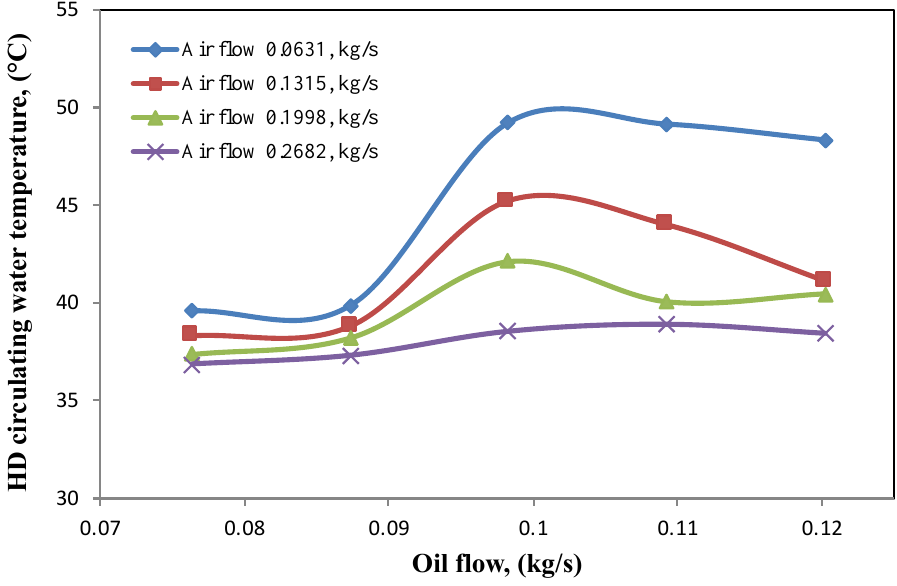
Figure 11. Average HD water temperature at different air and oil flow rates.